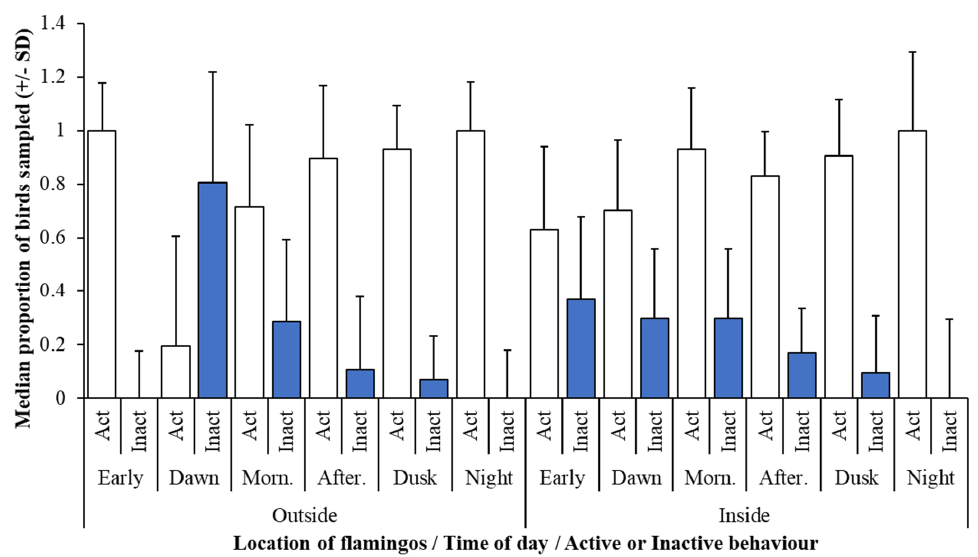
Figure 2. Median proportion of birds observed as active or inactive for the total number of obser- vations from six different times of the day both in the outdoor enclosure and in the indoor house. Morn. = Morning time code and After. = Afternoon time code. Abridged on the figure for clarity of the X axis. Table 2. Post-hoc comparison of outdoor activity by time of day. Significant differences are marked with an